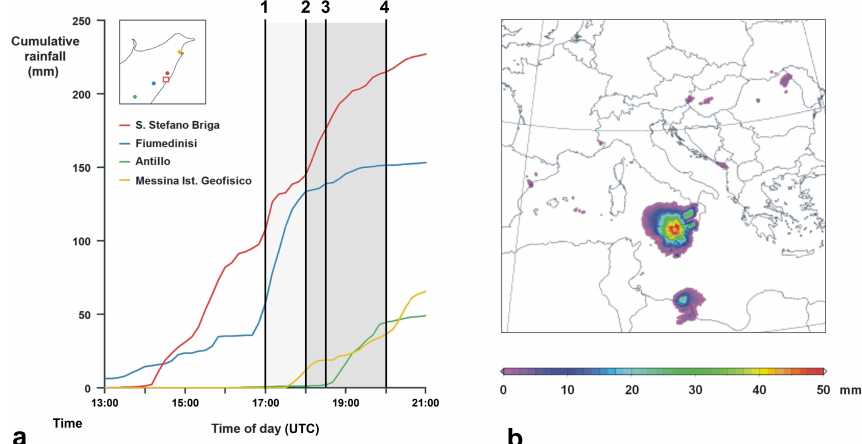
Figure 2. (a) Cumulative hyetographs recorded at the four rain gauge stations (Santo Stefano di Briga, Fiumedinisi, Antillo and Messina Istituto Geofisico), whose locations are shown in the sketch on the upper left (the red square represents the study area). The shaded areas indicate the landslide timing during the event, on the basis of witness reports: 1 – first landslide events in Giampilieri (17:00–17:15UTC); 2 – beginning of the most critical stage, with the triggering of hundreds of shallow landslides in Giampilieri and the surrounding areas (18:00UTC); 3 – landslides in Molino (18:30–18:45UTC); 4 – end of the landslide events (20:00UTC); (b) accumulated rainfall between 18:00 and 21:00UTC, based on radar (satellite) data (from Melfi et al.,